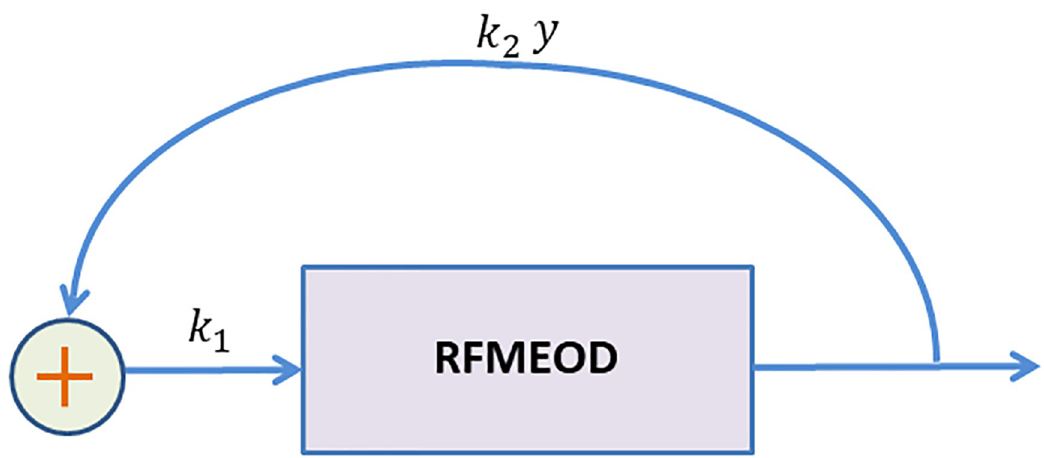
Fig 16. The EFEIOD with feedback where parameters k 1 and k 2 represents the constant source and recycling rate of ribosomes respectively. The term y ¼ l